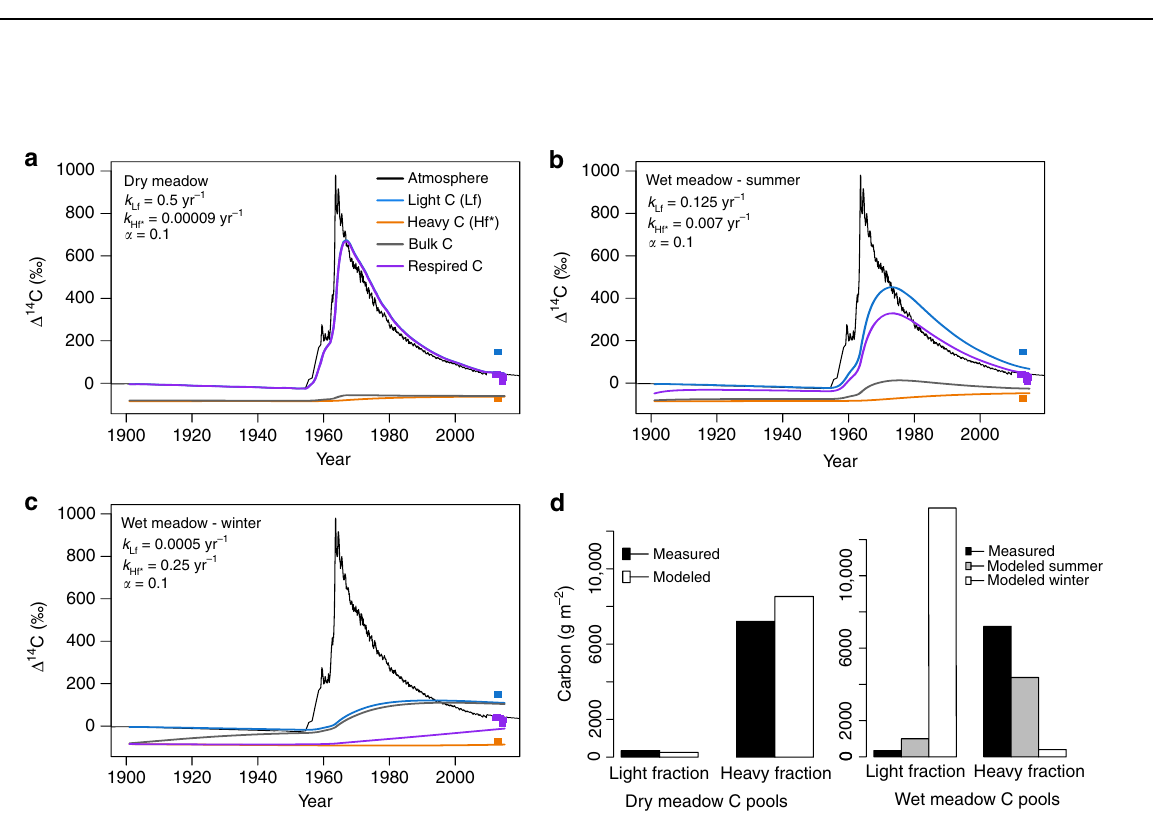
Fig. 4 Radiocarbon modeling indicates wintertime respiration of older carbon from wet meadow control points on soli fl uction lobes. Model results from the a dry meadow, b wet meadow (summer), and c wet meadow (winter) scenarios show a lower decay rate of light fraction carbon ( k Lf ) and a higher decay rate of heavy plus occluded light fraction carbon ( k Hf* ) at the wet meadow site during winter. The input partitioning parameter ( α ) describes the fraction of the light carbon pool that is transferred to the heavy carbon pool at each time step. d Seasonal comparison of modeled versus measured Lf and Hf* carbon fractions suggests non-steady-state carbon cycling at the wet meadow site, i.e., seasonal pools are not well